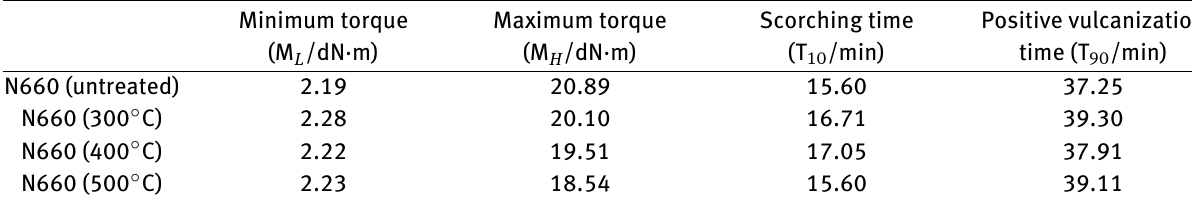
Table 6: Effect of high temperature treatment of CB on vulcanization characteristics of gross rubber